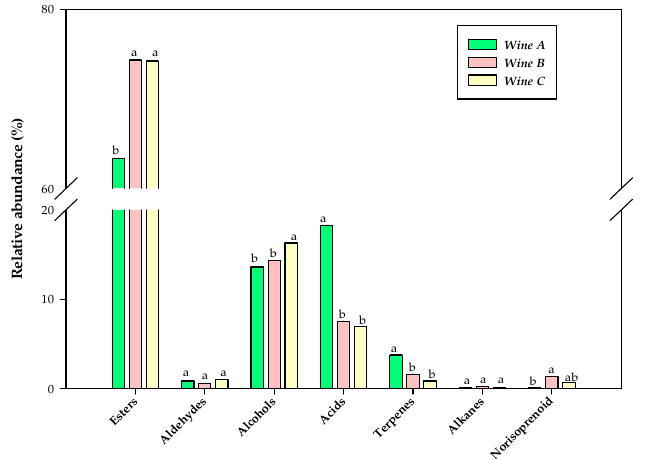
Figure 1. Chemical families in the volatile profiles of the studied wines as affected by the type of vessel used for the aging step. Bars with the same letter, within one chemical family, were not significantly different ( p > 0.05), according to Tukey’s least significant difference test. Table 2. Descriptive sensory analysis of the studied wines as affected by the type of vessel used for the aging step ( A : aged in clay- tinaja with non-permeable inner coating; B : aged in clay- tinaja without inner coating; C : aged in oak barrels).